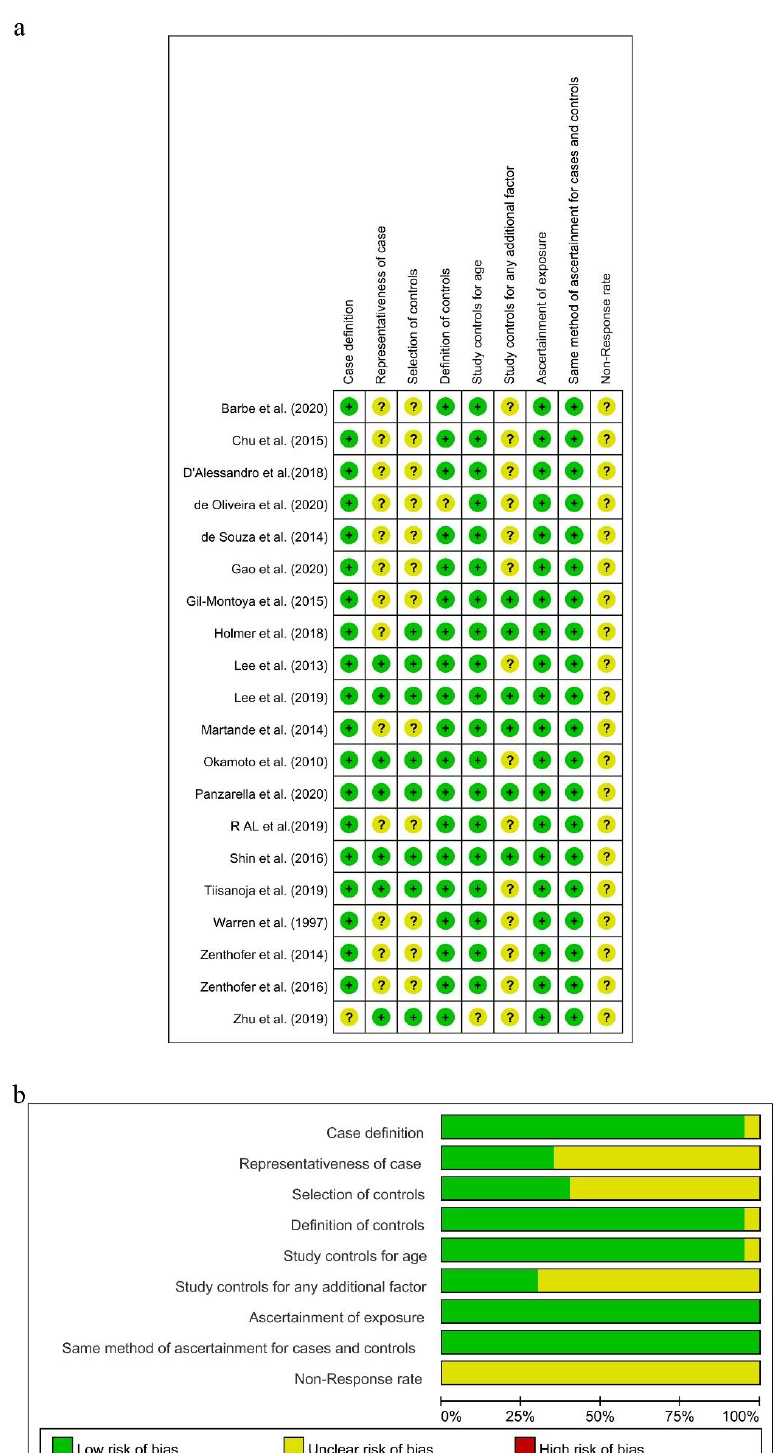
Figure 2. Risk of bias summary ( a ) and risk of bias graph ( b ) for included studies, respectively.